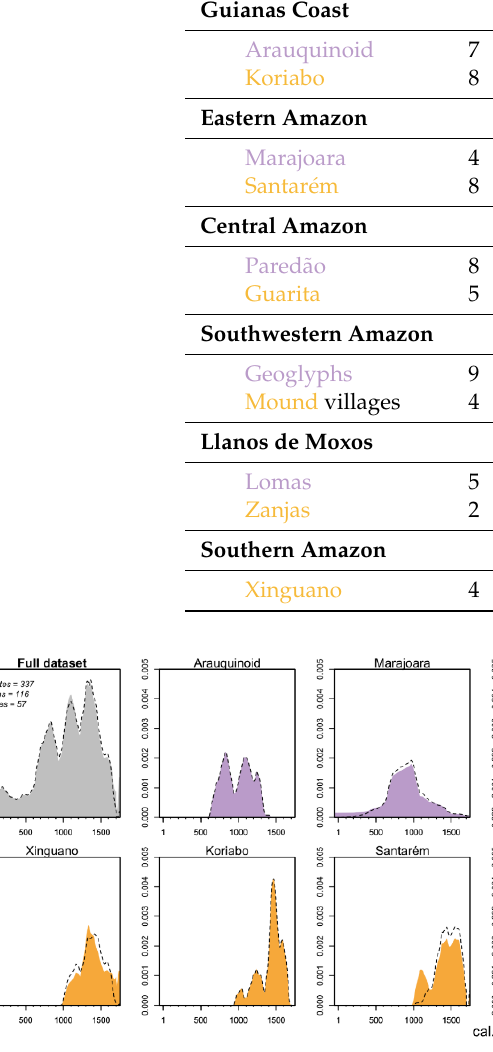
Figure 1. Comparison of normalised SPDs of full (filled envelopes) and limited (dashed line) datasets. Phases have been paired in columns (purple: “intensive”, orange: “extensive”) by region and plotted on a common y-axis. Xinguano dates are unpaired. Withheld dates affect the SPDs unevenly. The four subsets most affected (Santarém, Guarita, Paredão, Xinguano) have their ranges truncated to be narrower.